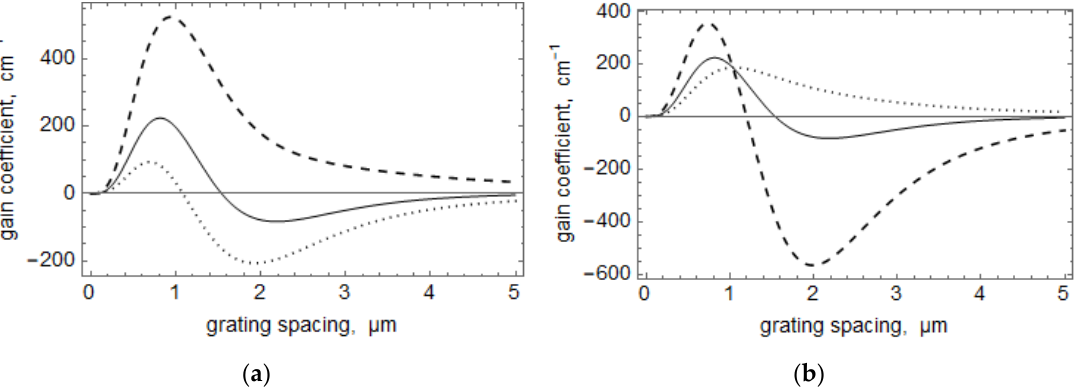
Figure 5. Influence of the splay and bend director deformations on the gain coefficient at p = L . ( a ) e 1 / K = 0.1 (dotted), 1 (solid), 3 (dashed), e 3 / K = 1; ( b ) e 3 / K = 0.1 (dotted), 1 (solid), 3 (dashed), e 1 / K = 1.